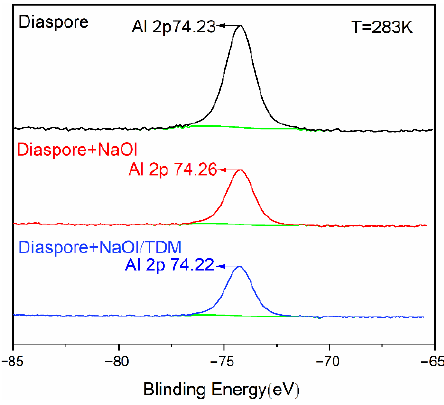
Figure 9. XPS spectra of the Al 2p layer of diaspore with different collectors at 283 K.